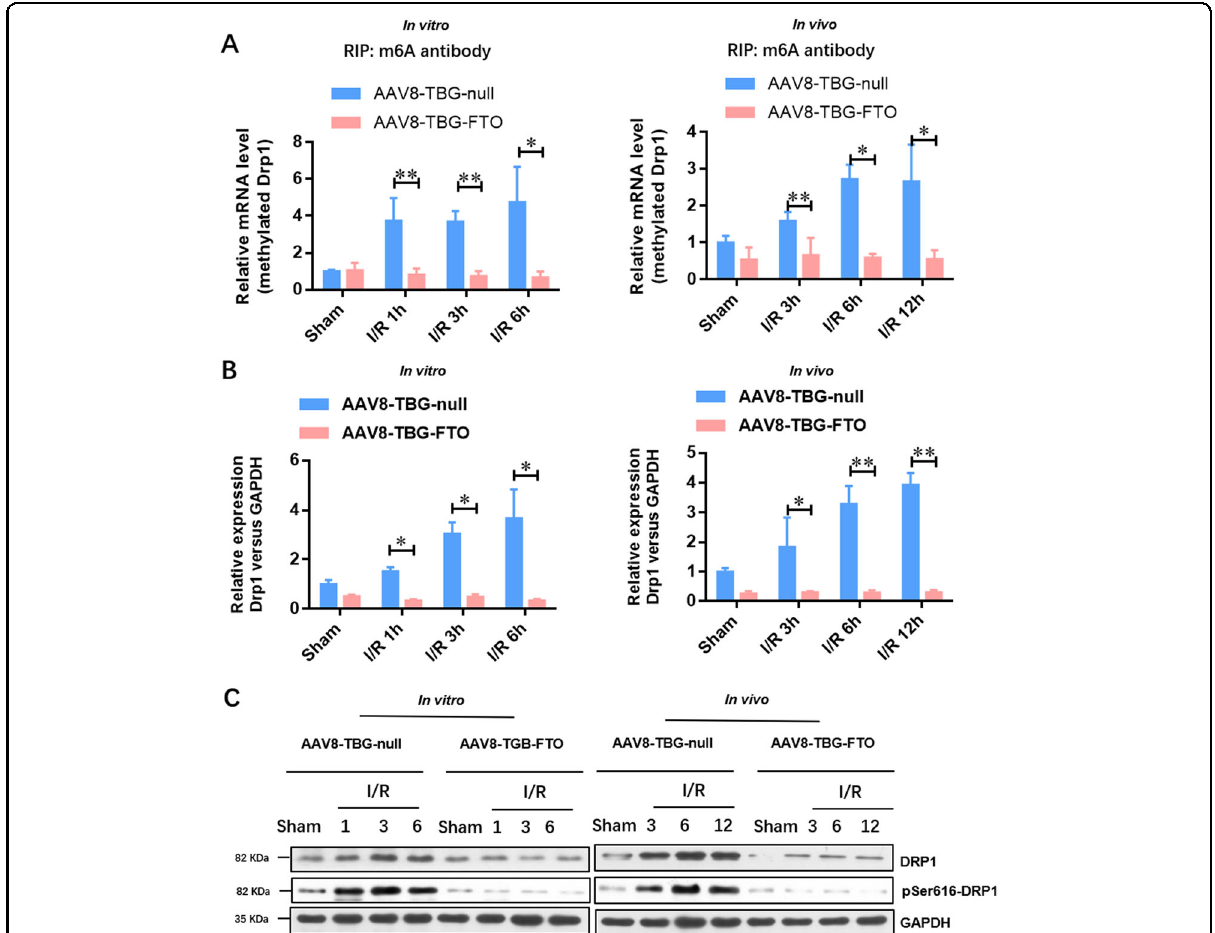
Fig. 5 Liver-speci fi c overexpression of FTO suppresses the IRI-elevated expression of Drp1 in hepatocytes upon IRI in vivo and in vitro. A Me-RIP qRT-PCR analysis was performed to evaluate the methylated Drp1 RNA level in the hepatocytes and hepatic tissues infected with control AAV8-TBG-null and AAV8-TBG-FTO during IRI. B qRT-PCR was adopted to analyze the expression of Drp1 at the mRNA level in the hepatocytes and hepatic tissues infected with control AAV8-TBG-null and AAV8-TBG-FTO during IRI. C Western blotting analysis was used to verify the expressions of total and activated Drp1 (pSer616) at the protein level in the hepatocytes and hepatic tissues infected with control AAV8-TBG-null and AAV8-TBG-FTO during IRI. N = 3; * P < 0.05 and ** P < 0.01 vs. AAV8-TBG-NC